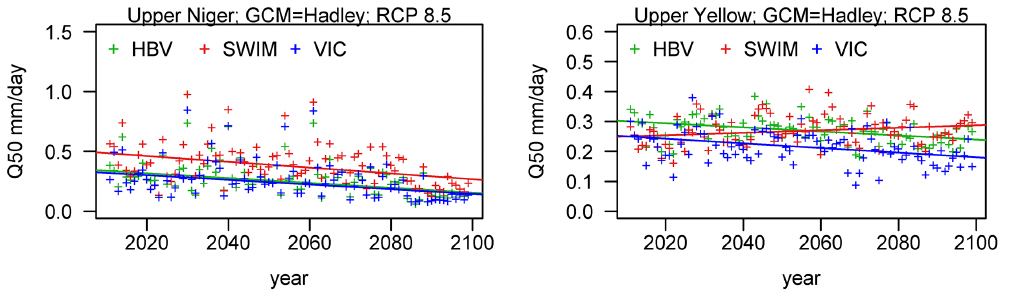
Figure 7. Two examples showing annual median flows Q 50 estimated from simulations by three models driven by the Had climate scenario data corresponding to RCP8.5 and the corresponding trend lines (all presented trends are significant) for the Upper Niger (left panel) and Upper Yellow (right panel) in the period